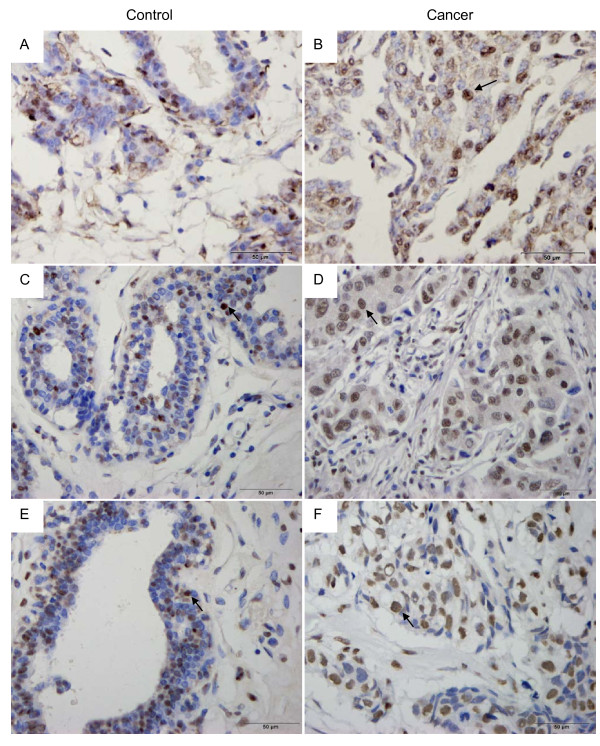
Representative photomicrographs. Immunohistochemical expressions for histone deacetylase 1 (HDAC1), acetyl-histone H3 (H3Ac) and acetyl-histone H4 (H4Ac) in breast invasive ductal carcinomas (IDC) and fibroadenomas (FA) (×400). (A), (C), (E) breast fibroadenomas; (B), (D), (F) breast invasive ductal carcinoma. Immunostained for HDAC1 (A, B), H3Ac (C, D) or H4Ac (E, F). nuclear staining (arrow).